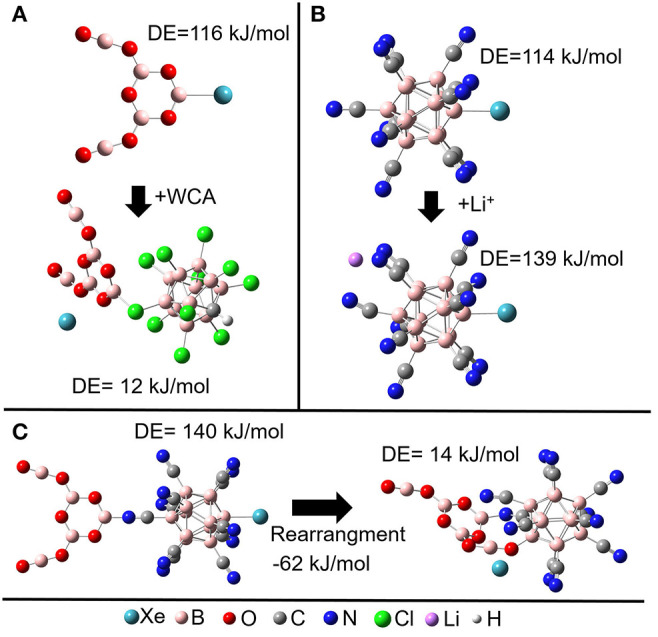
Effect of ion pairing on the 0 K dissociation enthalpy (DE) of Xe (A) Combinations of the WCA [HCB11Cl11]- with [B5O7Xe]+. (B) Combination of Li+ with [B12(CN)11Xe]−. (C) Combination of [B5O7]+ with [B12(CN)11Xe]−: a rearrangement is thermochemically preferred and results in the loss of the vacant boron site which binds the NG.